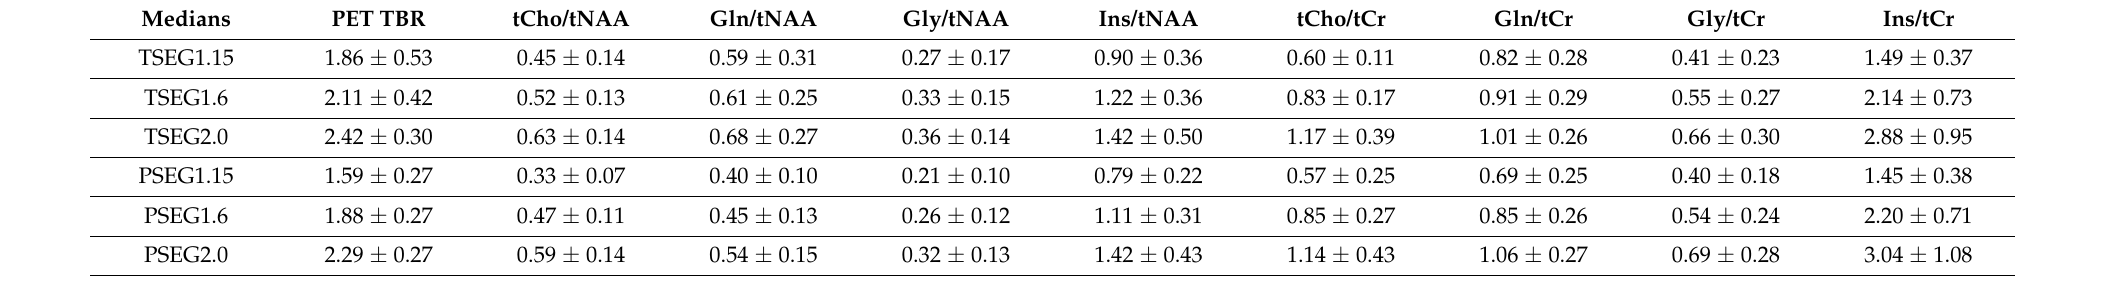
Table 6. VOI medians for all ratios and VOI